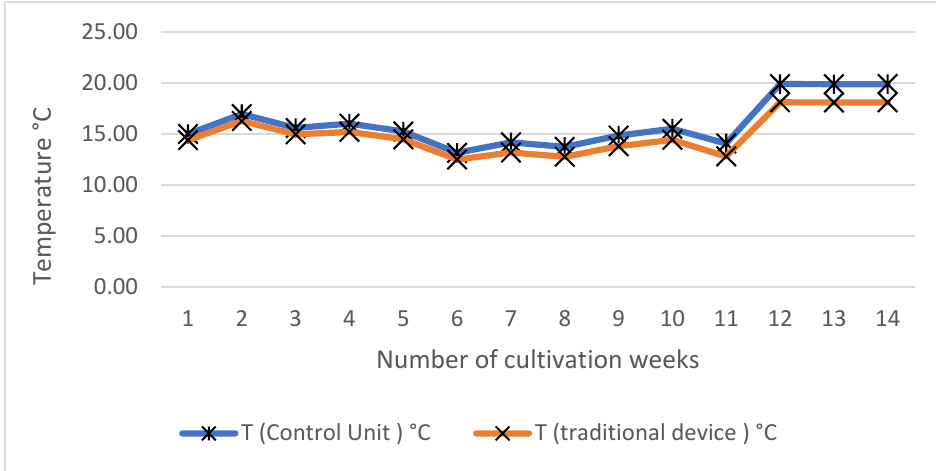
Figure 6. Results of T from an Arduino microcontroller system and traditional devices by week.